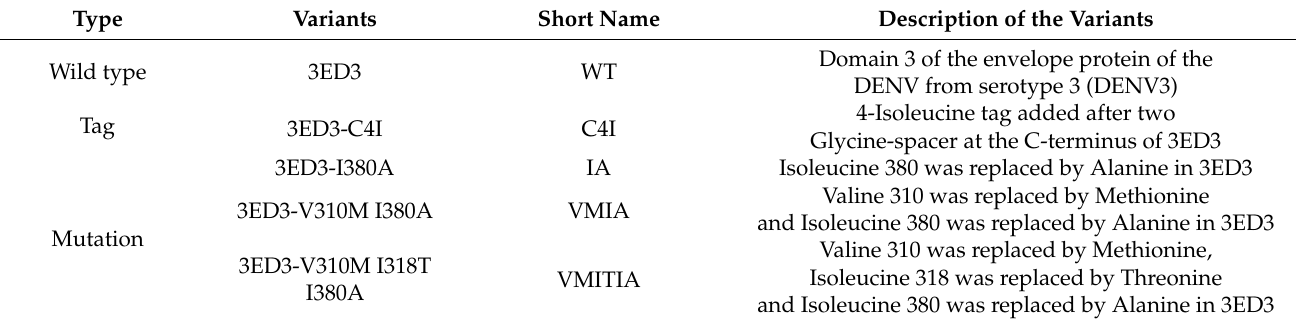
Table 1. DENV3-ED3 variants and their